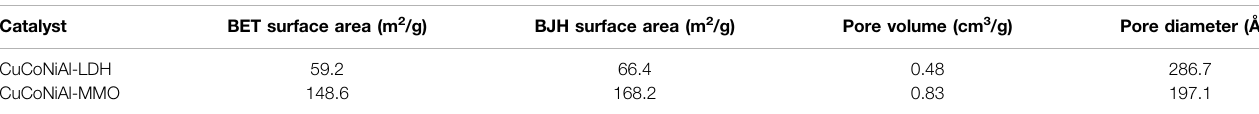
TABLE 1 | Summary of N 2 physisorption-data for CuCoNiAl-LDH and CuCoNiAl-MMO.